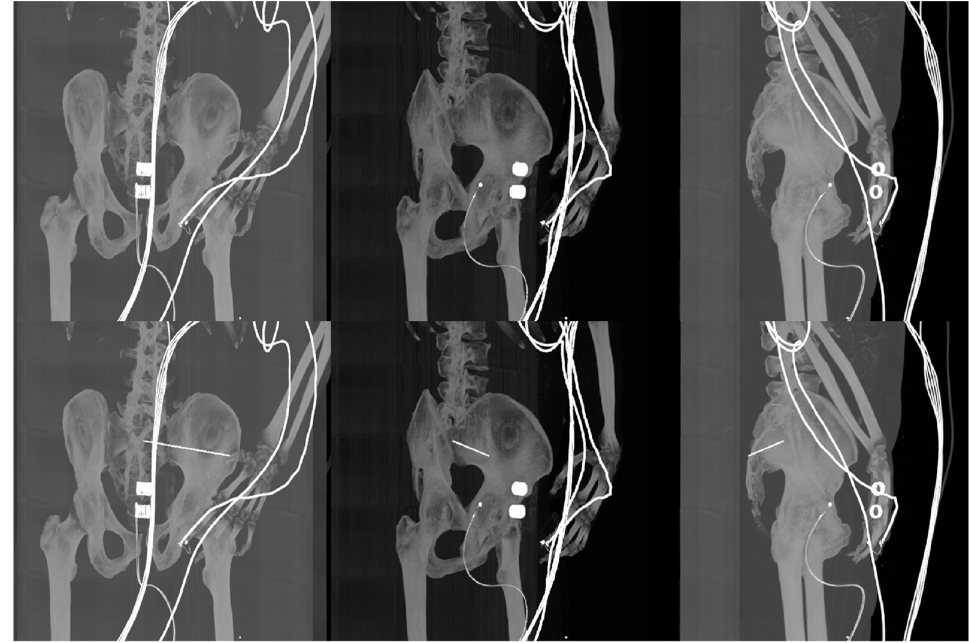
Figure 14. Comparison of three various CT slices ( Top Row ) of patient 2 with the same DDR projections with virtual iliosacral screw ( Bottom Row ).